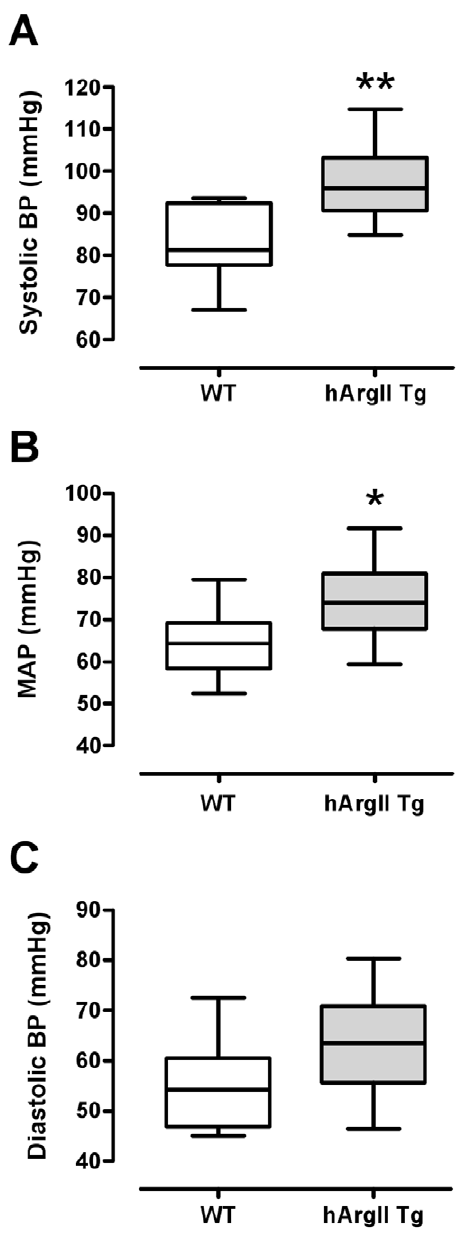
Figure 4. Blood pressure of anaesthetized hArgII and non- transgenic mice presented as box plots of A systolic blood pressure (systolic BP), B mean arterial pressure (MAP) and C diastolic BP. The box extends 25 th percentile to the 75 th percentile with the median represented by the line within the box. Measurements were from control non-transgenic sibling males (n=9) versus Line 4 and 11 hArgII males (n=9). Values were compared using unpaired Student’s t-tests where * = P , 0.05 and **P = ,